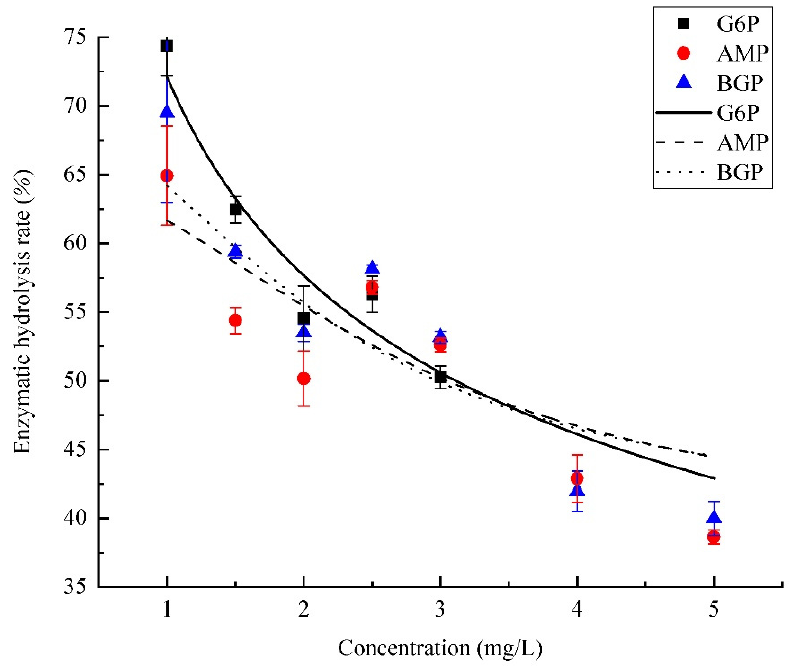
Figure 3. Effects of organic phosphorus concentration on PhoA mineralization.